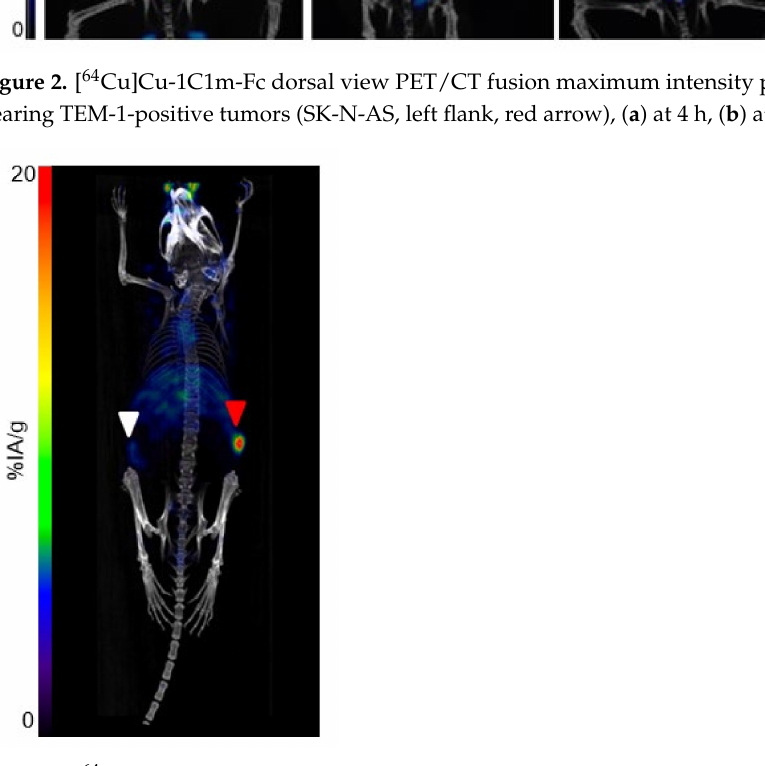
Figure 3. [ 64 Cu]Cu-1C1m-Fc dorsal view PET/CT fusion maximum intensity projection at 24 h on mouse bearing TEM-1-negative tumor (HT-1080; left flank; white arrow) and TEM-1-positive tumor (SK-N-AS; right flank; red